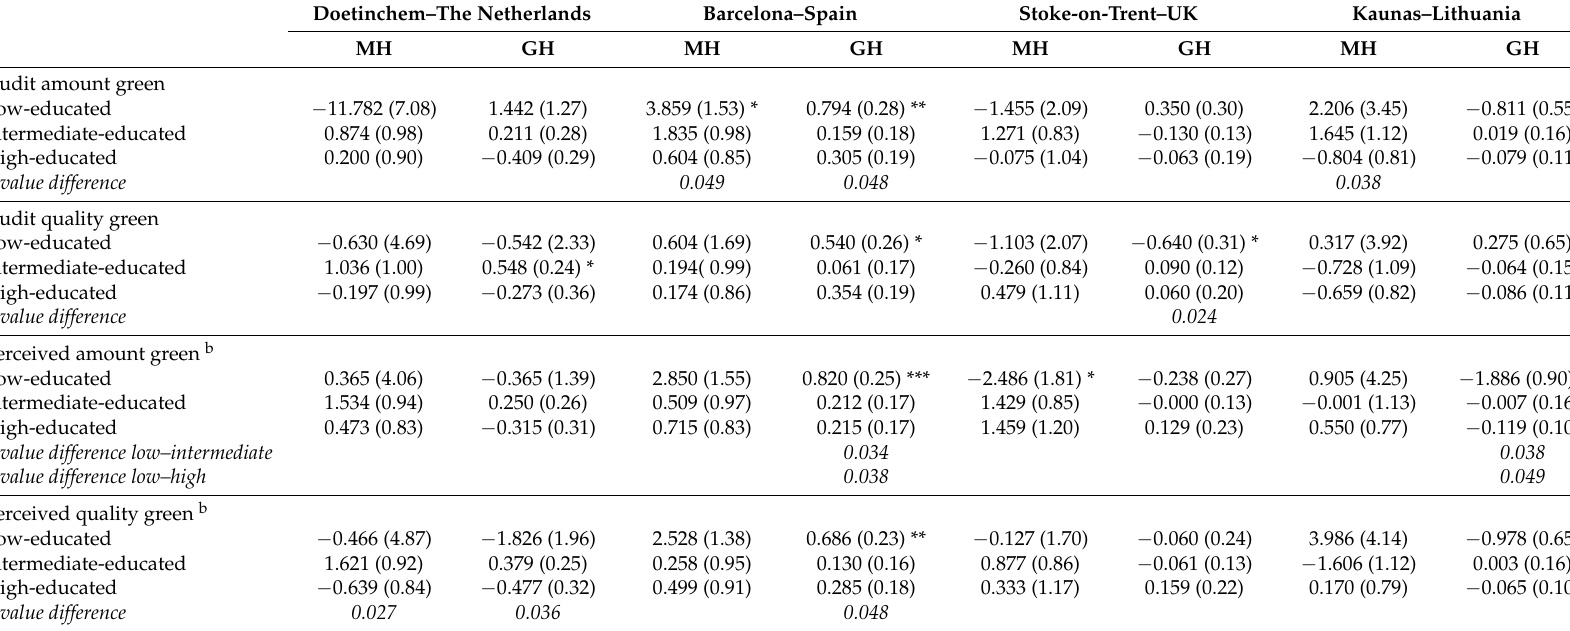
Table 3. Multilevel regression analysis for the relationship between neighbourhood-level green space (standardised estimates) and mental health (MH) and general health (GH) (standard errors in parentheses), by education (the p -value is provided for significant differences between subgroups) a